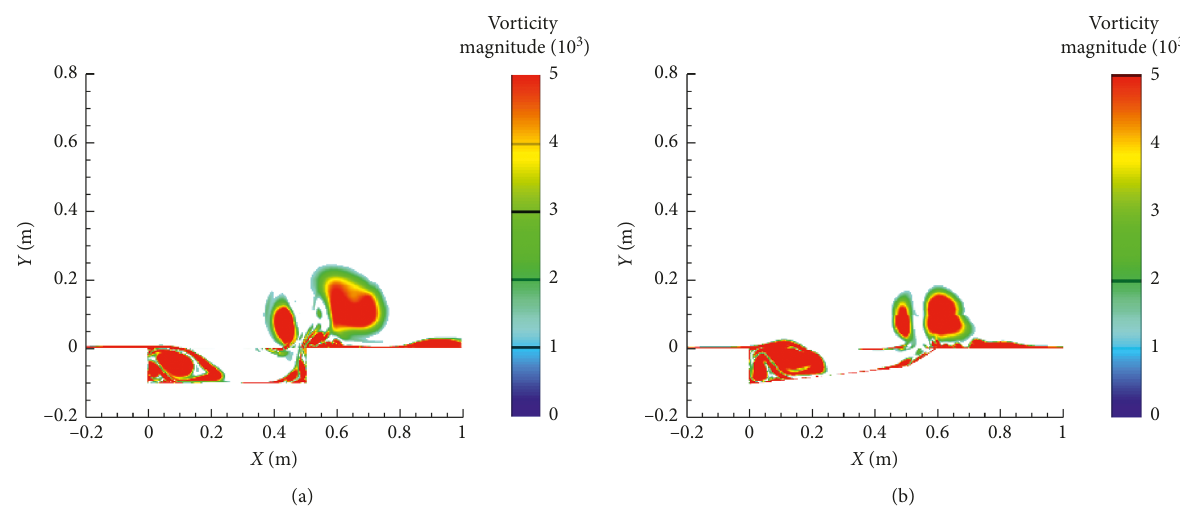
Figure 9: Comparison of the instantaneous vorticity contours of the rectangle cavity ( α � 0 ° ) at t � 5/6 T (a) and deformable cavity ( α � 60 ° ) at t ′ � 5/6 T ′ (b).